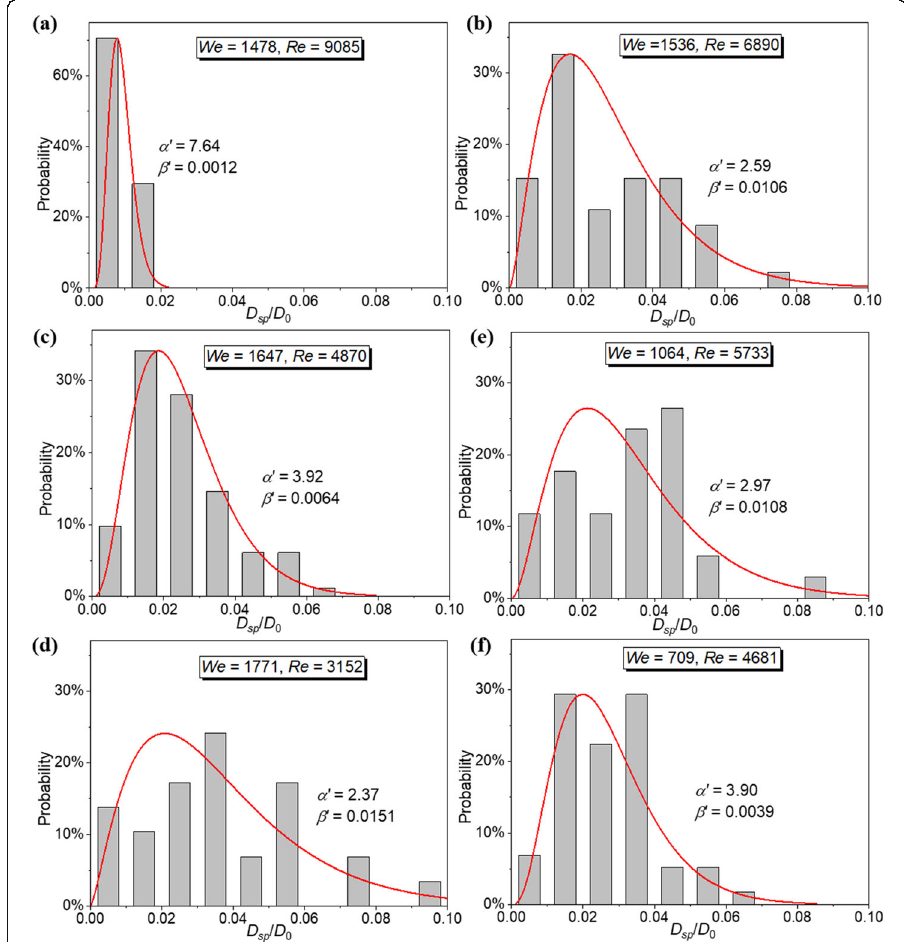
Fig. 4 Probability distribution of dimensionless diameter D sp / D 0 of splashing secondary droplets under different impact conditions: a 20% glycerol solution, D 0 = 3.7 mm, U 0 = 5 m/s, We = 1478, Re = 9085; b 30% glycerol solution, D 0 = 3.7 mm, U 0 = 5 m/s, We = 1536, Re = 6890; c 40% glycerol solution, D 0 = 3.7 mm, U 0 = 5 m/s, U We = 1771, Re = 3152; e 30% We = 1647, Re = 4870; d 50% glycerol solution, D 0 = 3.7 mm, 0 = 5 m/s, glycerol solution, D 0 = 3.7 mm, U 0 = 4.1 m/s, We = 1064, Re = 5733; f 30% glycerol solution, D 0 = 3.7 mm, U 0 = 3.4 m/s, We = 709, Re = 4681. The red curve in each figure indicates the Gamma distribution fitting